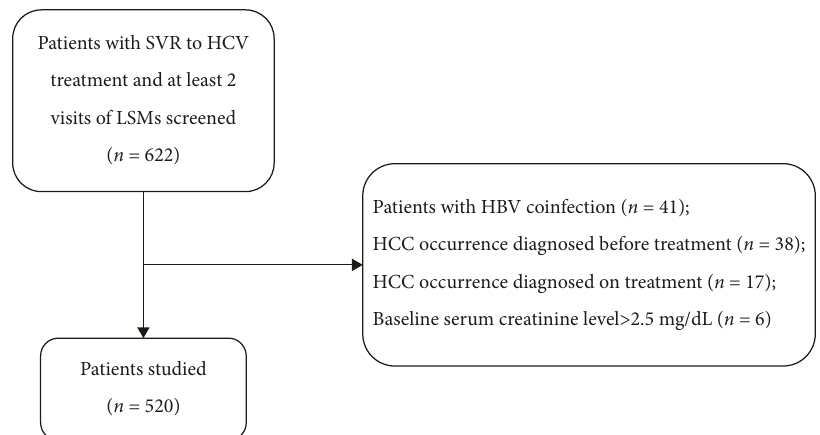
Figure 1: Patient recruitment flow chart. HBV, hepatitis B virus; HCC, hepatocellular carcinoma; HCV, hepatitis C virus; LSM, liver stiffness measurement; SVR, sustained virologic